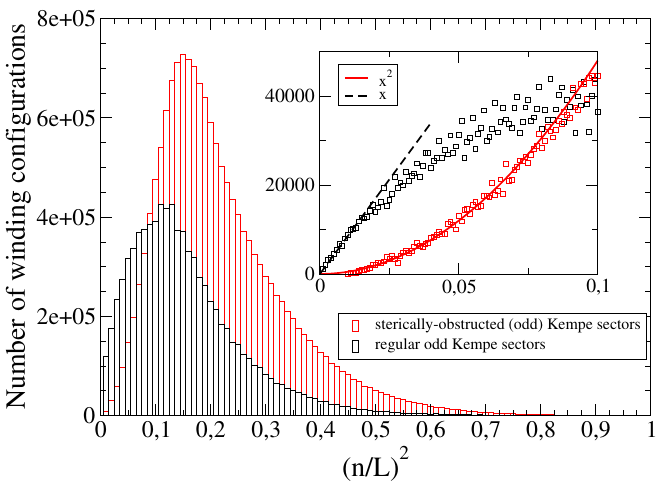
Figure 12: Probability distribution of norms, n 2 in winding loop configurations, for regular odd sectors and sterically-obstructed (odd) Kempe sectors ( L = 150). Small norms (see inset) are absent from the latter: linear (dashed line) and quadratic (solid line) fits are